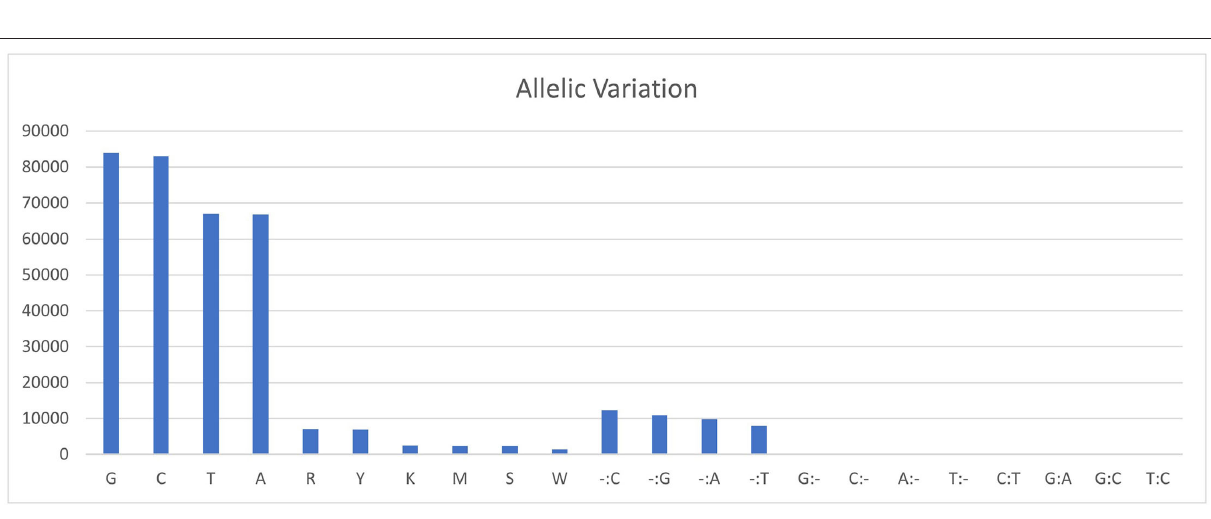
of the red, blue, and green groups, respectively. PCA showed that the first and the second principal components explained